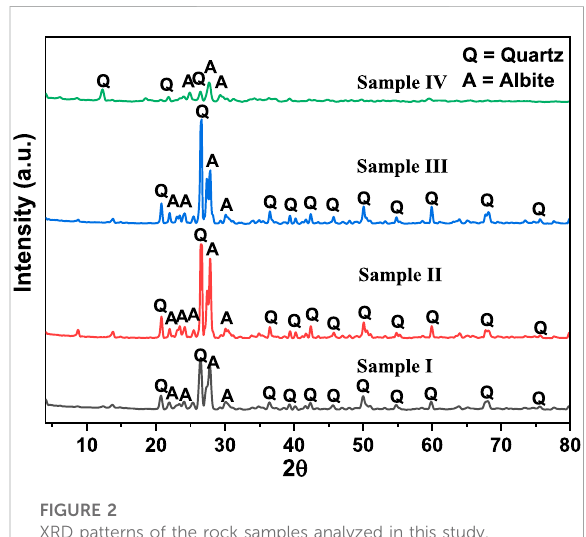
FIGURE 2 XRD patterns of the rock samples analyzed in this study.